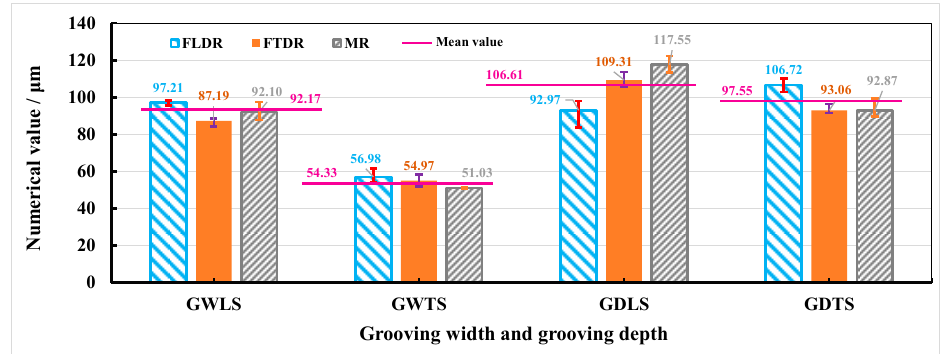
Figure 7. Grooving depth and width in different regions under laser power of 14 W and repetition frequency of 12 kHz.